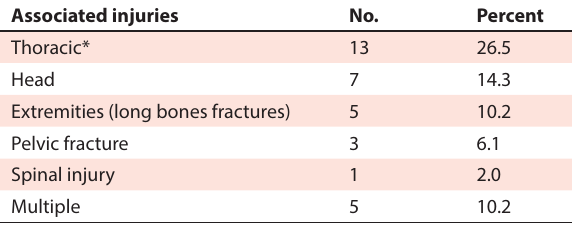
Table 3. Associated extraabdominal injuries with BAT